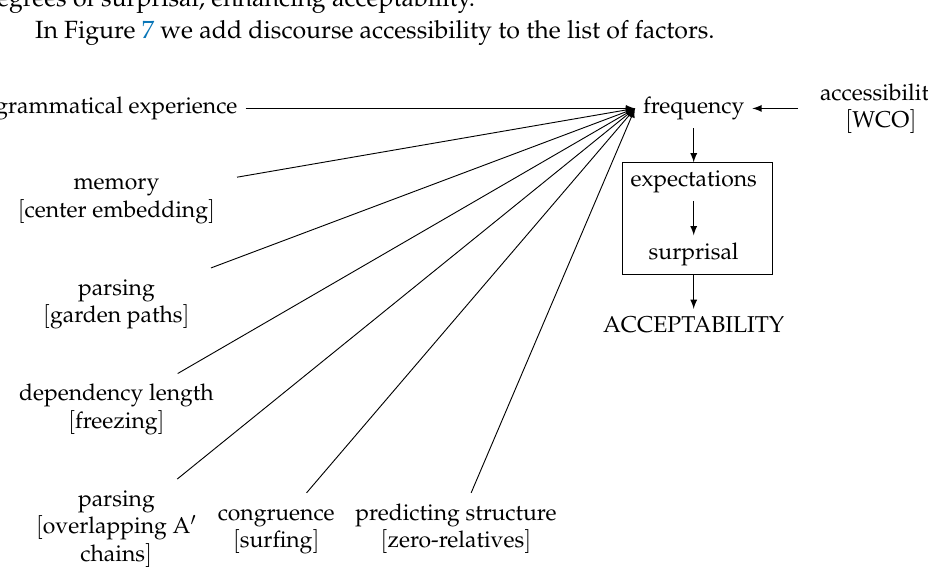
Figure 7. The logic of acceptability judgments for grammatical conditions, version